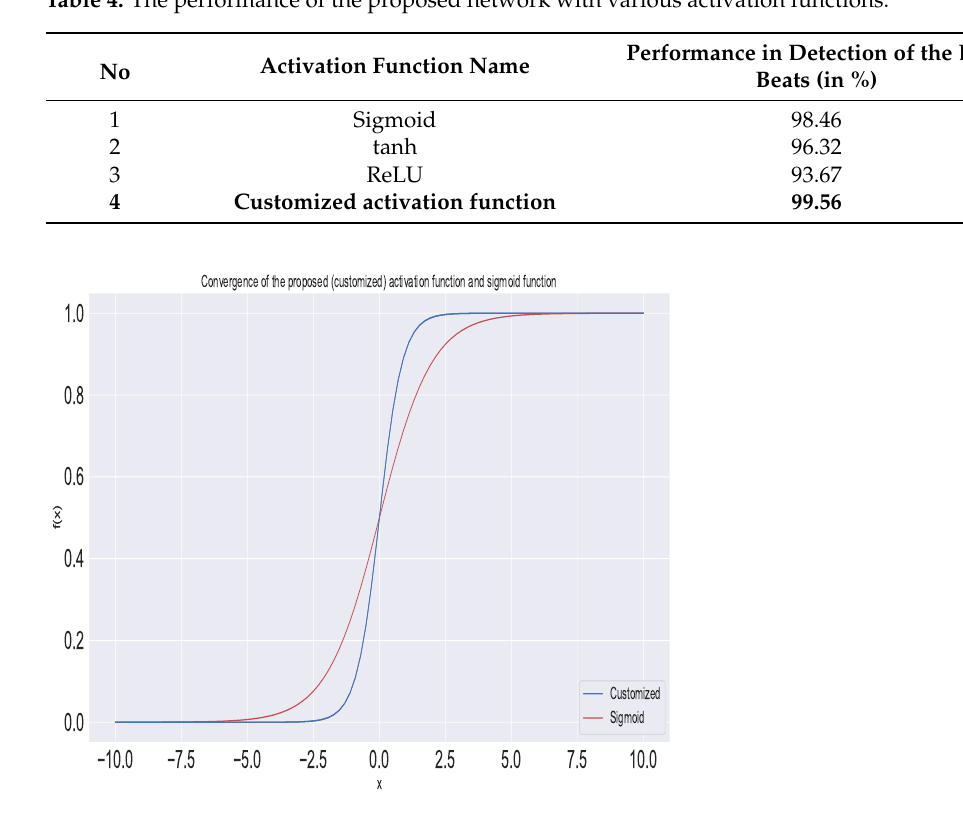
Figure 3. Convergence of the proposed (customized) activation function and the sigmoid